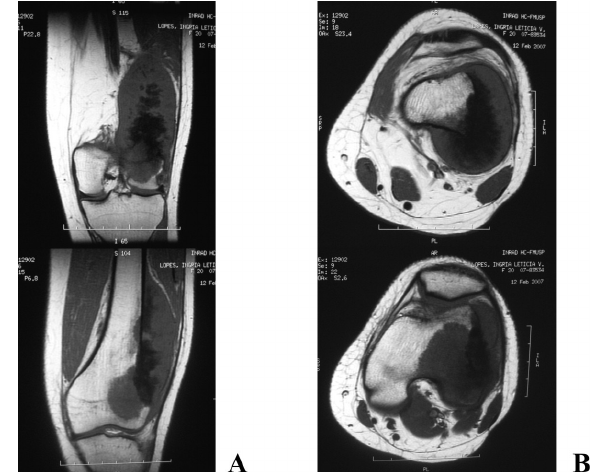
Figure 1 - Magnetic resonance images demonstrating the tumor expansion process (osteosarcoma) in the distal metaphysis and epiphysis of the left femur and affecting soft tissues (extra-compartmental). Coronal (A) and axial (B) T1